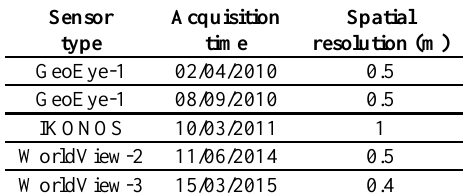
Table 1. Data acquisition for VHR satellite data. 1